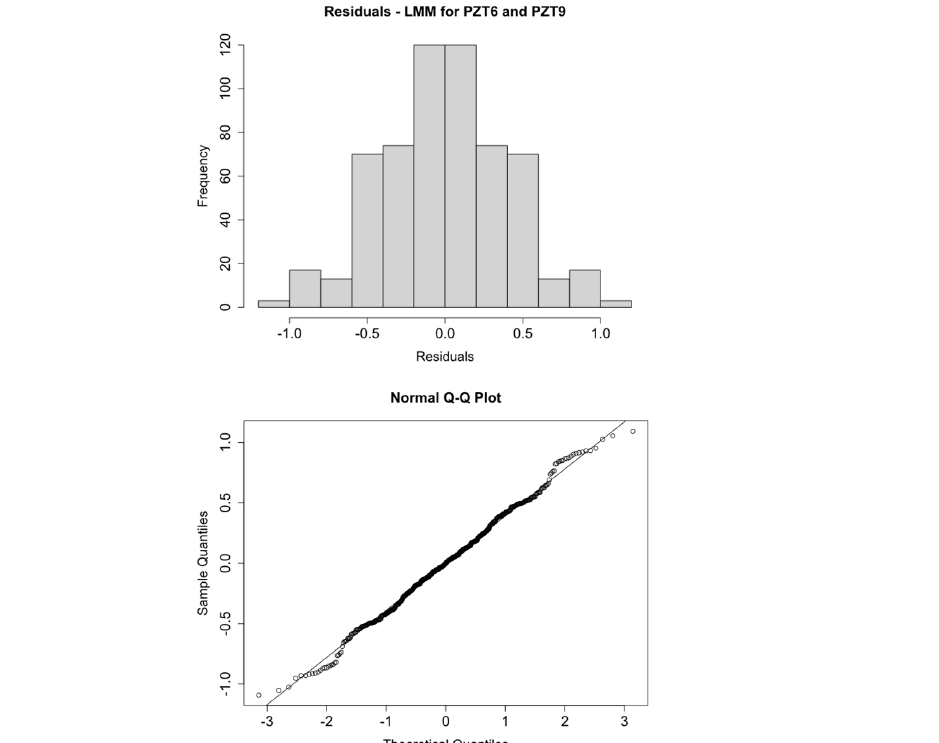
Figure 10. logRMSD histogram and Q-Q plot—Group 2.